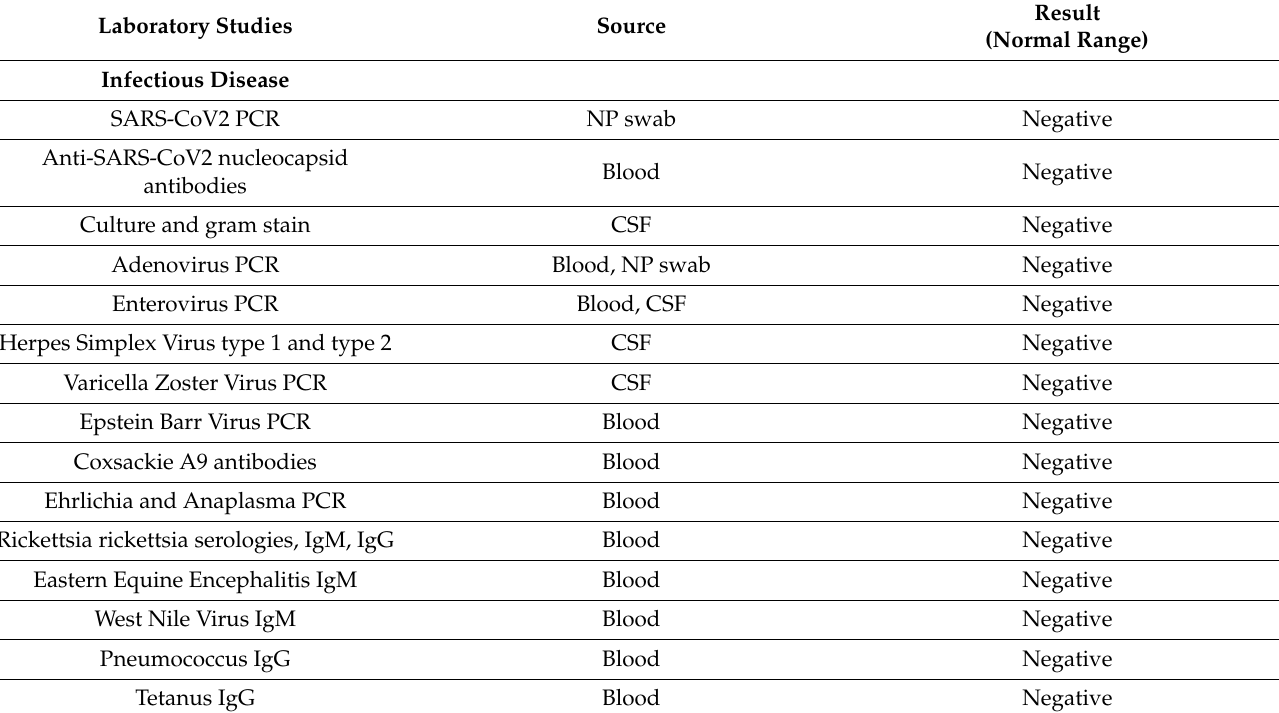
Figure 2. Cytotoxic lesion of the corpus callosum. Axial T2 image ( A ) shows focus of T2 prolongation representing cytotoxic edema in the splenium of corpus callosum (arrow) with reduced diffusivity on trace diffusion image ( B ) (arrow) and apparent diffusion coefficient map ( C ). Table 1. Diagnostic studies and results during hospital admission.